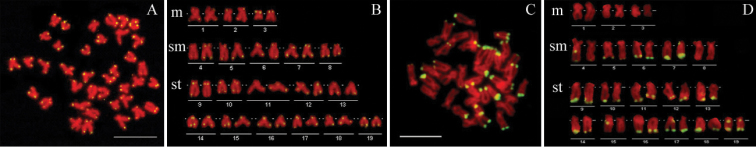
Metaphase chromosomes and karyotype of C.
farreri. FISH mapping with vertebrate telomeric sequence (TTAGGG)7 (A, B) and satellite DNA Cf303 (C, D). Scale bars: 5µm.